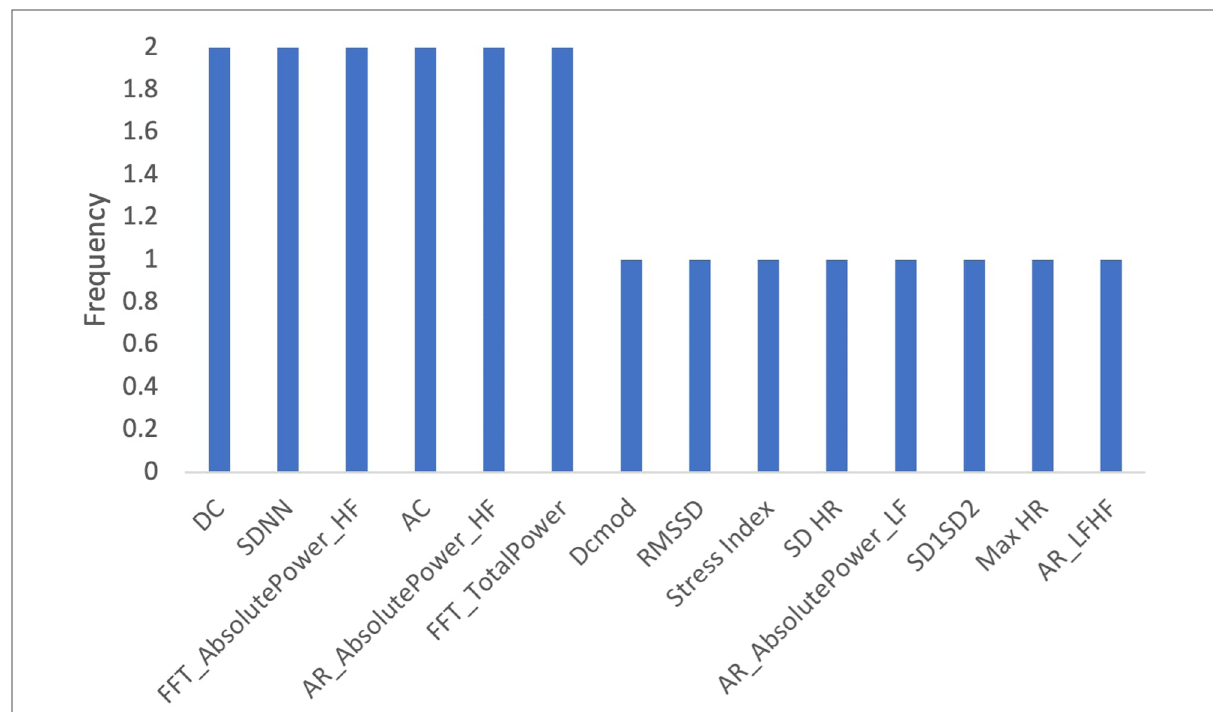
FIGURE 15 Frequency of features in income-related models.